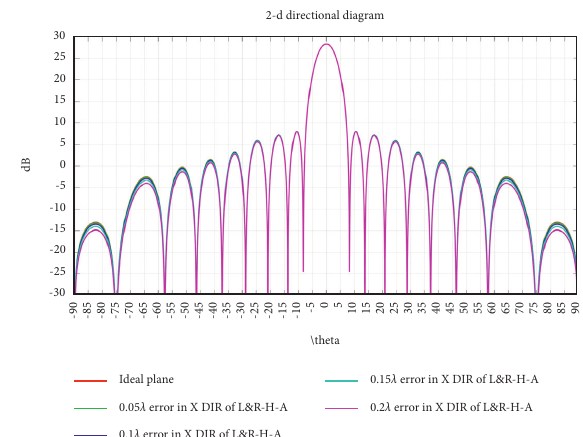
Figure 13: Change of the azimuth pattern caused by the position error of the left and right half arrays in the Y